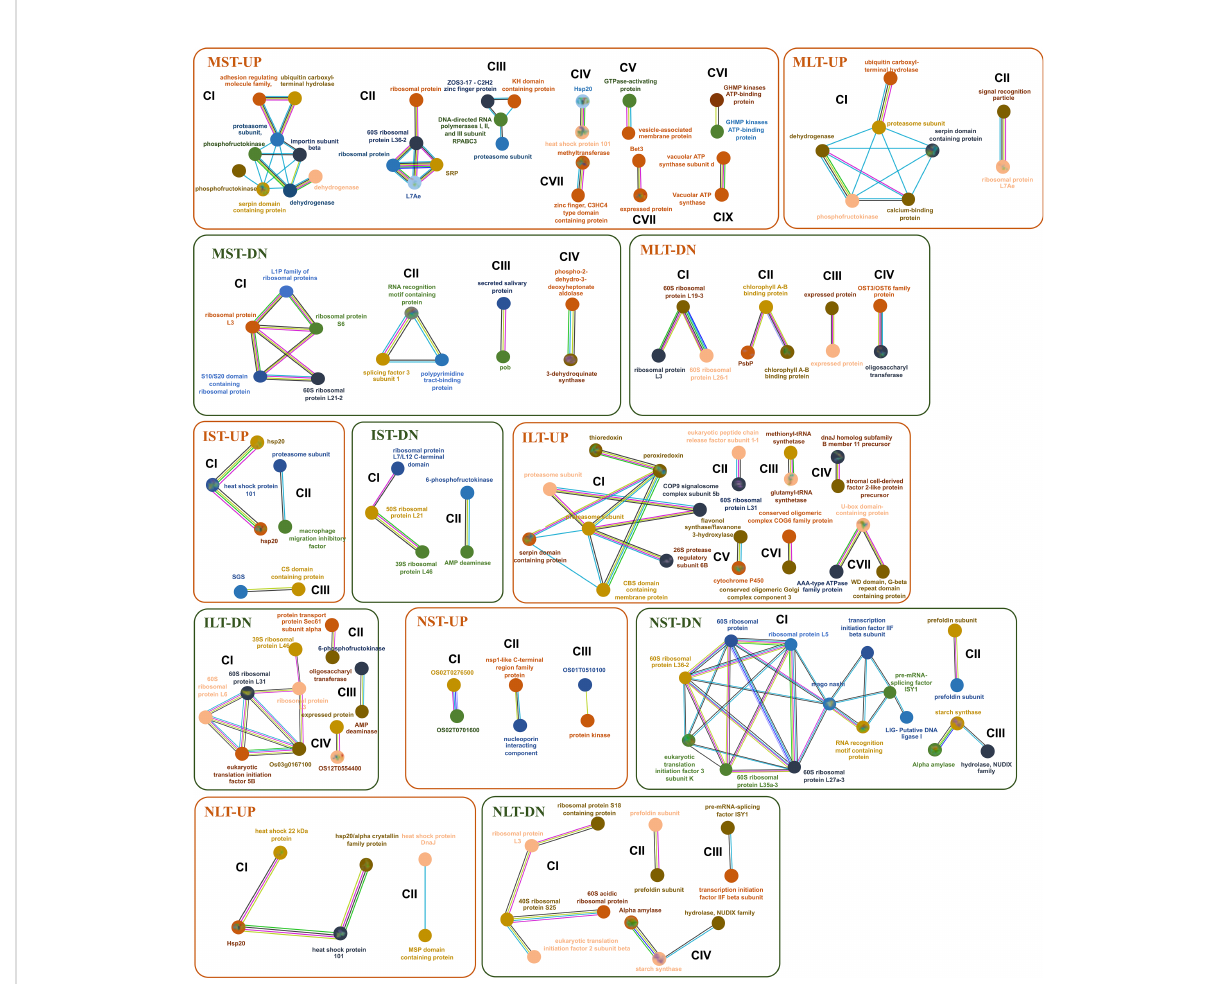
FIGURE 7 Protein interaction network pro fi les represent up- and down-regulated protein interactions in Moroberekan, IR64 and N22 in short-term heat stress conditions. The parameter was restricted with the highest con fi dence to 0.900 neglecting the single molecules found in the interaction map to best predict the interactions. Each circle represents a protein, and lines represent the type of evidence available for fi nding interactions between the two proteins. Redline- the presence of fusion evidence; Green line- neighborhood evidence; Blue line- cooccurrence evidence; Purple line- experimental evidence; Yellow line- text mining evidence; Light blue line- database evidence; Black line- co-expression evidence. ST, Short term heat stress; LT, Long-term heat stress; MC, Moroberekan control; MST, Moroberekan ST_HS; MLT, Moroberekan LT_HS, IC, IR64 control; IST, IR64 ST_HS; ILT, IR64 LT_HS; NC, N22 control; NST, N22 ST_HS; NLT, N22 LT_HS; UP, upregulated; DN,